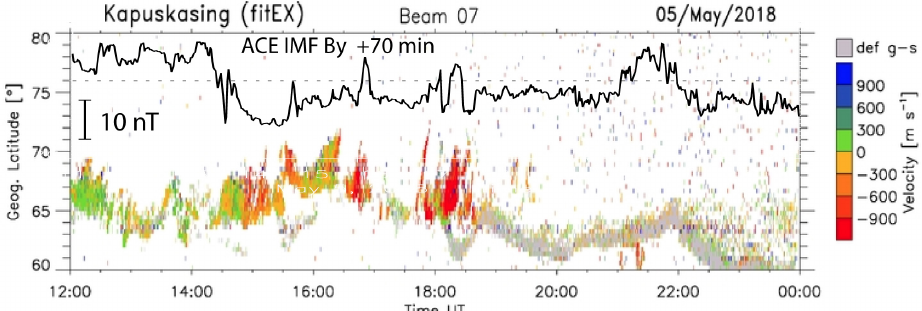
Figure 7. The Kapuskasing radar line-of-sight velocities as a function of geographic latitude and time (UT). The time-shifted IMF B y observed by ACE are superposed.